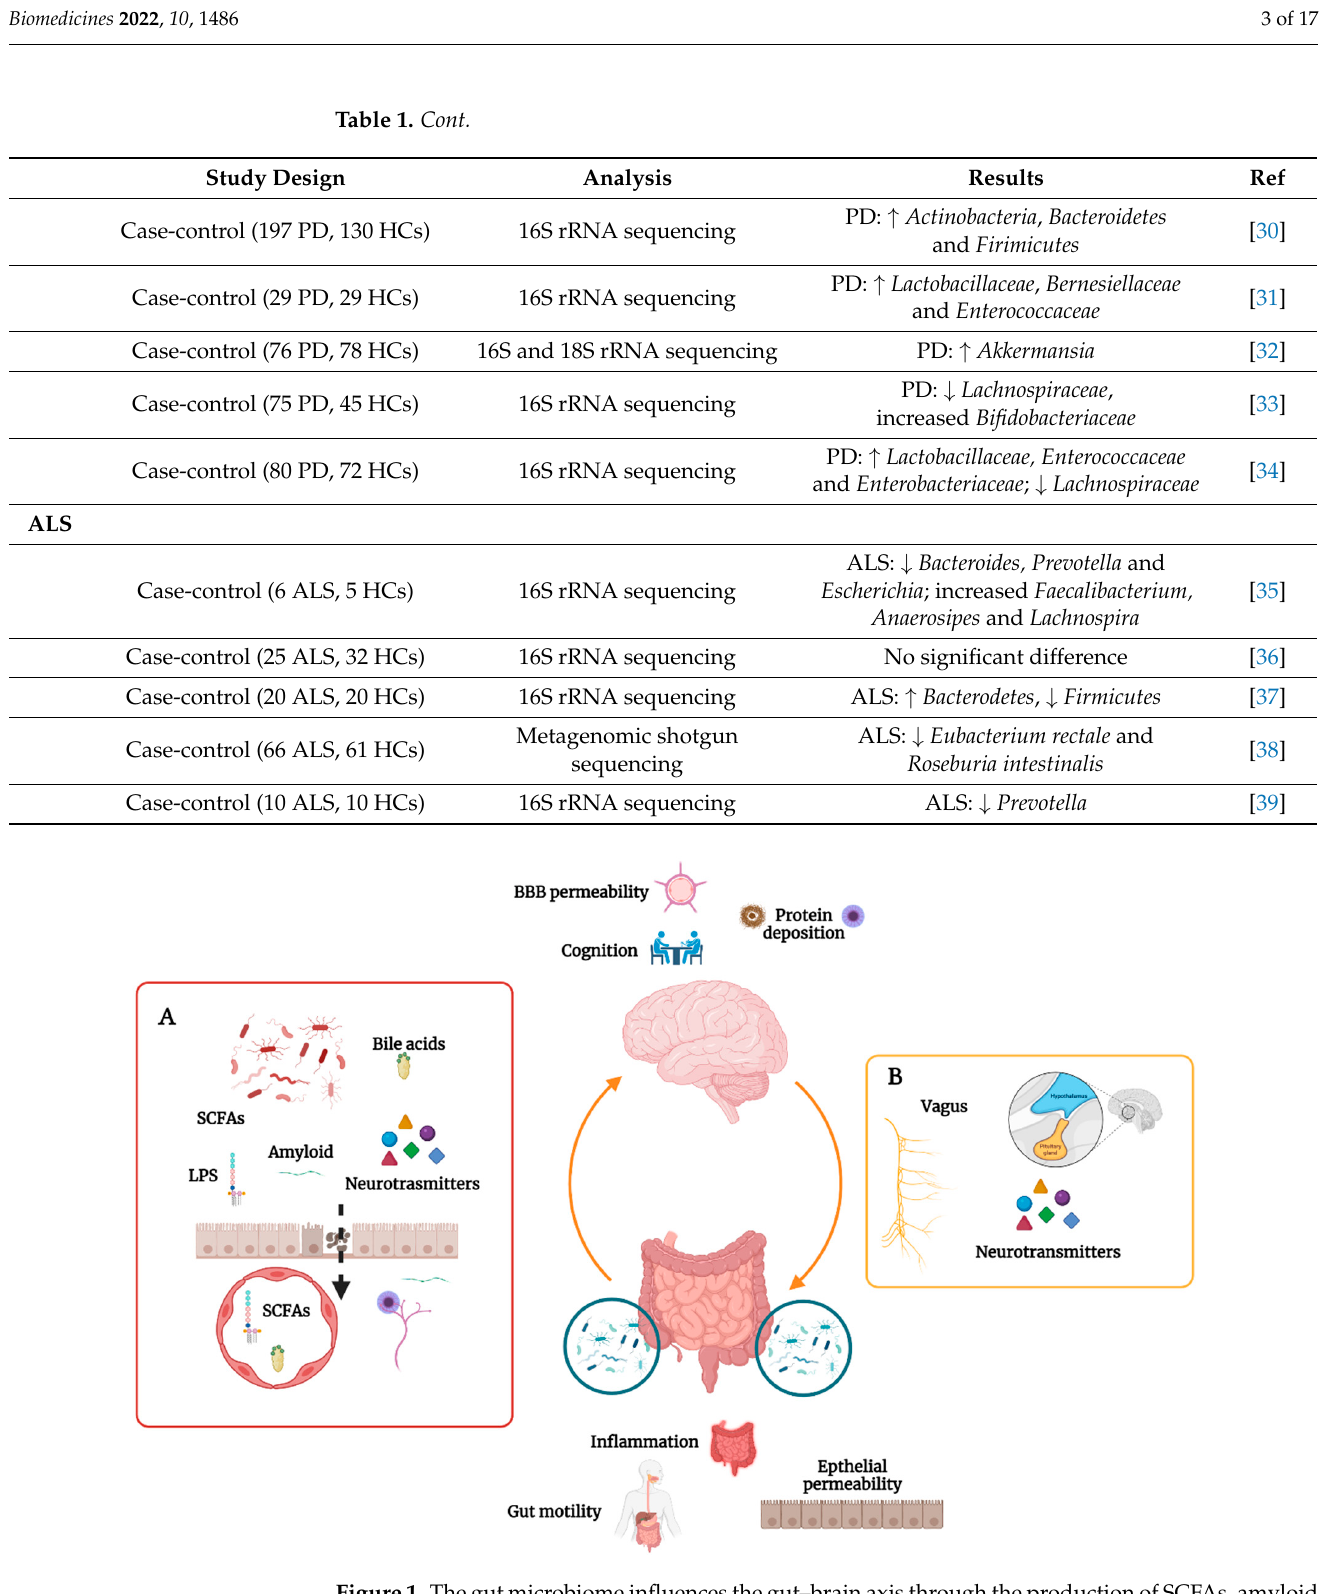
Figure 1. The gut microbiome influences the gut–brain axis through the production of SCFAs, amyloid proteins, LPS, bile acids, and neurotransmitters. SCFAs and bile acids can enter the circulation and have been demonstrated to have an important effect on maintaining BBB homeostasis. Amyloid proteins and LPS can increase local inflammation, promoting further local and systemic protein deposition ( A ). On the other hand, the CNS can control epithelial permeability, gut motility, and inflammation through the autonomic nervous system and the hypothalamus–pituitary axis ( B ). Created with BioRender.com.